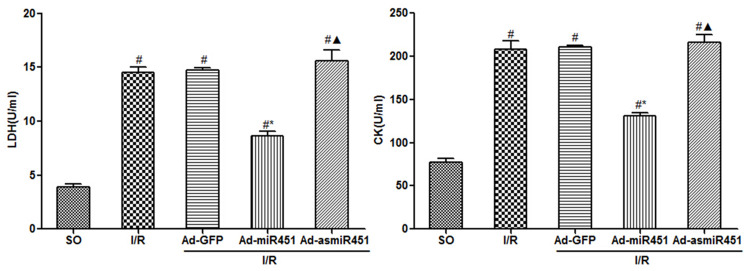
Effect of miR-451 on CK and LDH in I/R.#: vs P<0.05 compare with SO group; *: P<0.05 compare with I/R group; ▲: P>0.05 compare with I/R group.